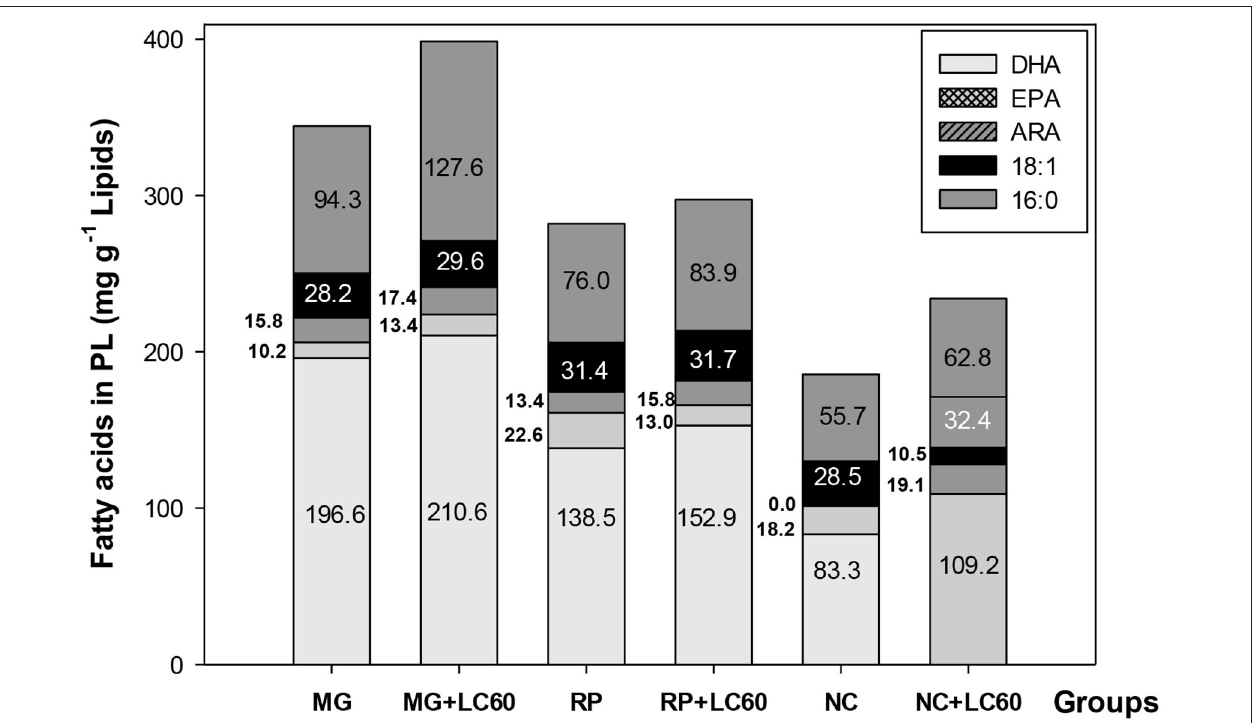
FIGURE 1 | Main fatty acid content (mg) in PL of meager larvae fed different enriched rotifers until 15